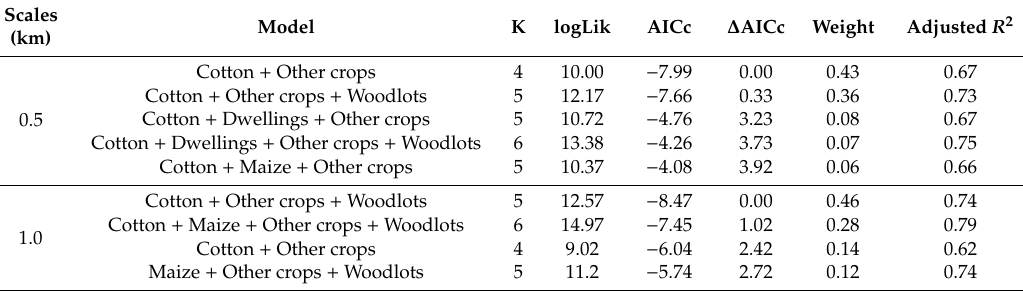
Figure 2. Relationships between the abundance of Apolygus lucorum in July and landscape variables with the best fitting model at each scale (0.5 km: ( a , b ); 1.0 km: ( c – e ); 1.5 km: ( f ); 2.0 km: ( g )), based on AICc analysis. The proportion of different landscape types cover was logit transformed and standardized. Table 1. List of models that were included in the top model set ( ∆ AICc < 4.0) for model averaging procedure, to infer landscape effects on the abundance of Apolygus lucorum in cotton fields in July. Best models at each scale are indicated in bold.